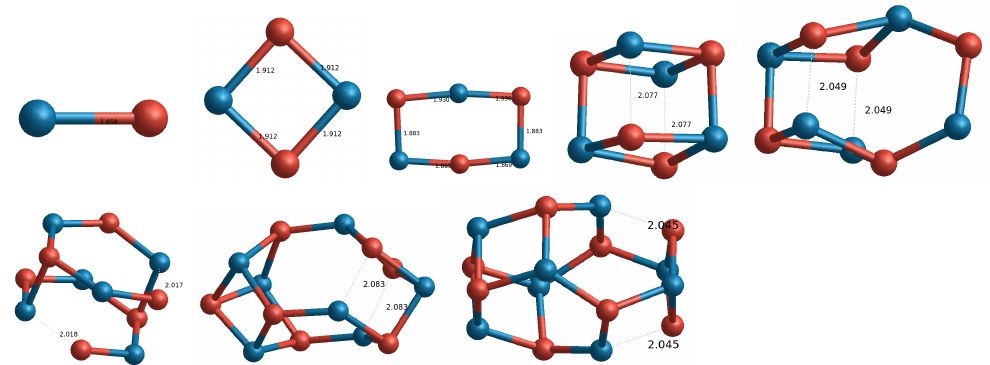
Figure 2. The adiabatically optimized structures of (MgO) n+ cations. Mg atoms are in blue; O atoms in red; numbers correspond to bond distances in